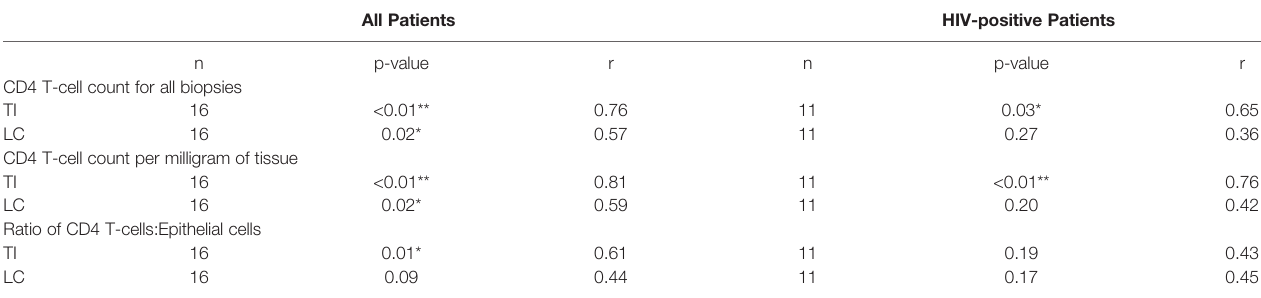
TABLE 2 | Relationship between systemic CD4 T-cell concentration measured using peripheral blood and measured gastrointestinal lymphocyte numbers, for all study groups combined, and for HIV-positive study participants only. All Patients